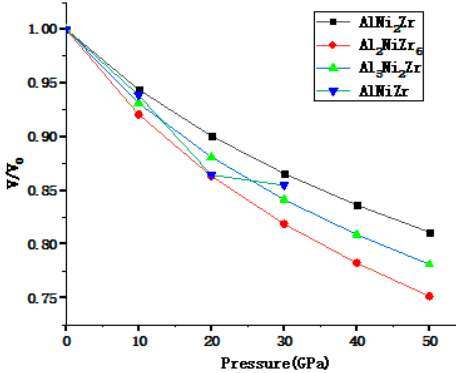
Figure 1. Calculated pressure dependence of the volume for Al x Ni y Zr z .